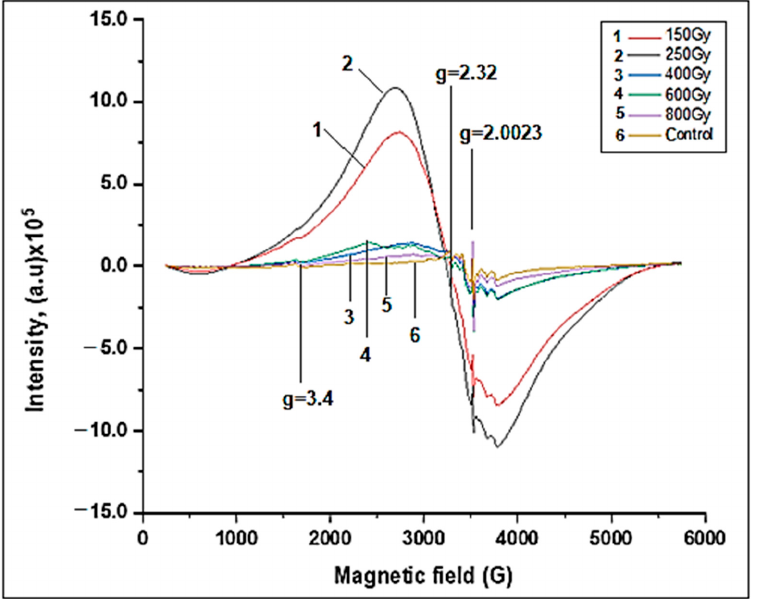
Figure 2. EPR spectra of body parts of old grape snails in the control and irradiated objects.